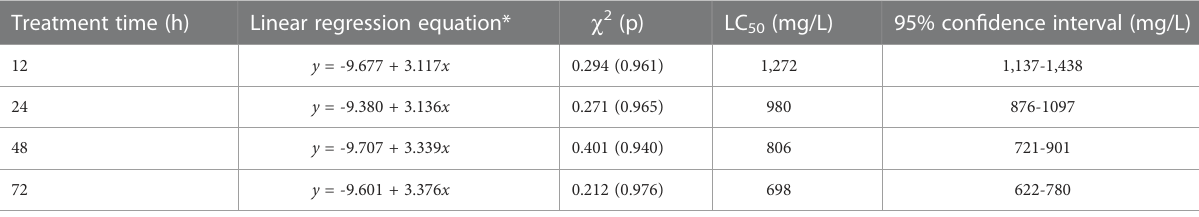
TABLE 3 Toxicity of L-nicotine on adult Diaphorina citri .